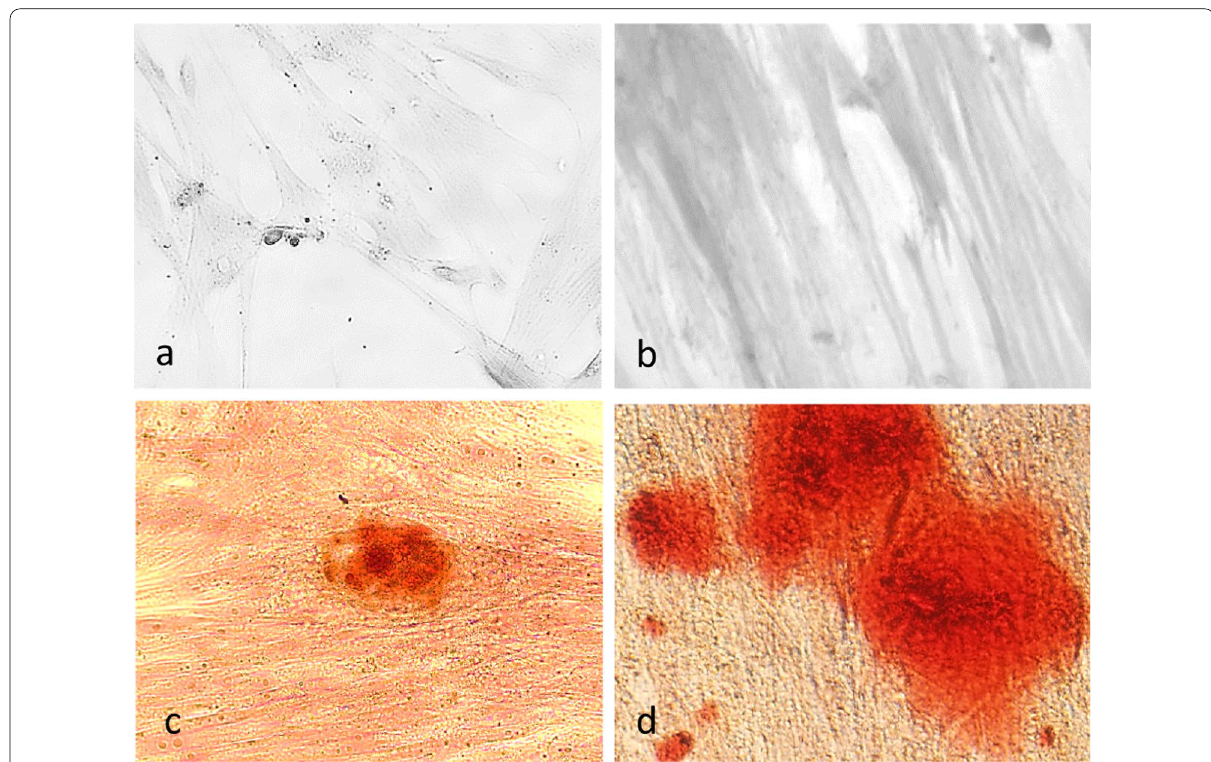
Fig. 10 After staining: a Control flask (20X Magnification, Phase contrast 2); b Control flask (40X Magnification, Phase contrast 3); c Calcium deposition represented by the red stain in the experimental flask (20X Magnification, Phase contrast 2); d Calcium deposition represented by the red stain in the experimental flask (40X Magnification, Phase contrast 3) as observed under inverted microscope Olympus 1X73